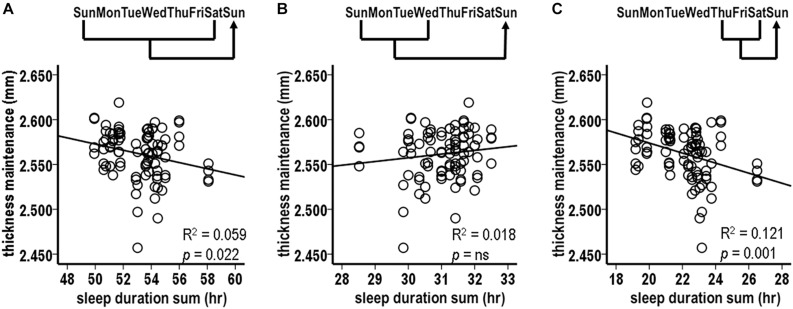
Relationships between preceding sleep durations and subsequent thickness maintenances from tests comparing accumulated sleep durations over preceding Sunday-Saturday week (A), Sunday-Wednesday early week segment (B), and Thursday-Saturday latter week segment (C) periods vs. thickness maintenances on subsequent Sundays. Fluctuations in sleep durations over preceding week (A) and latter week segment (C) periods were significantly inversely related to subsequent thickness maintenance.